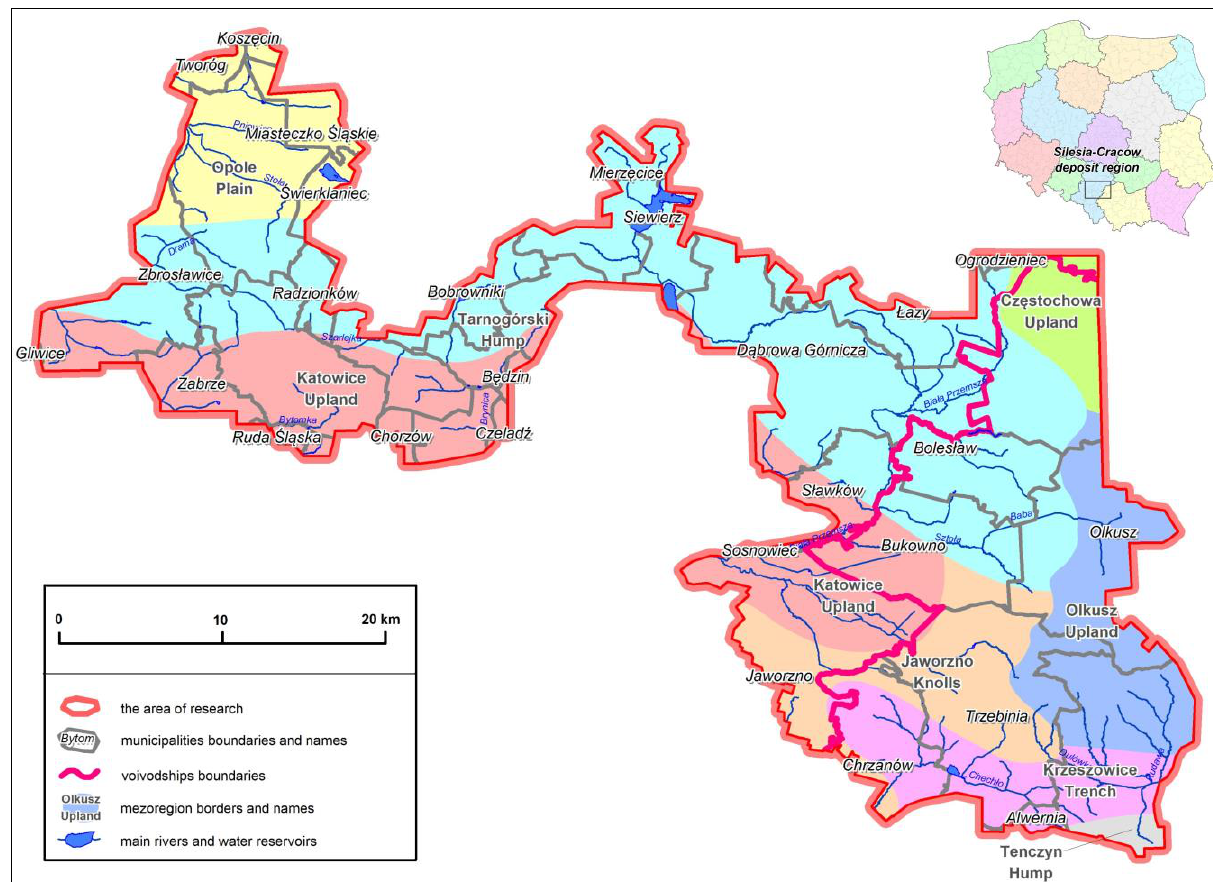
Fig. 1. The research area (http://dm.pgi.gov.pl and